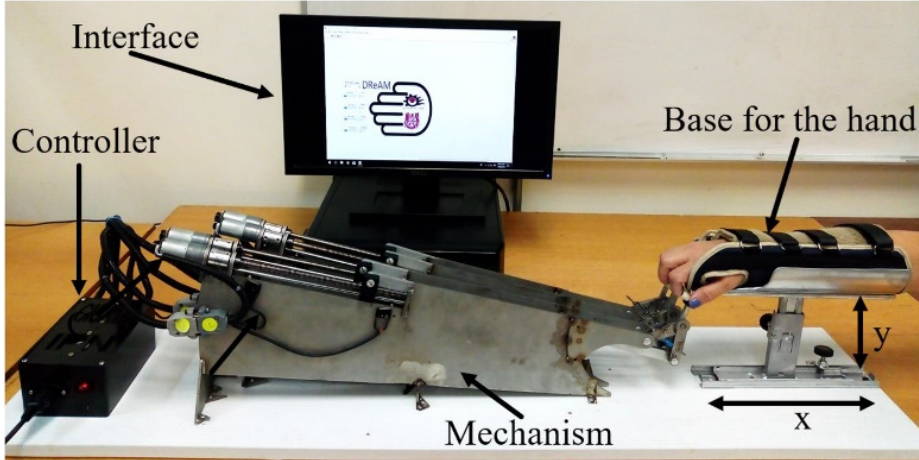
Figure 12. A-AFiM Figure 12. A-AFiM prototype.